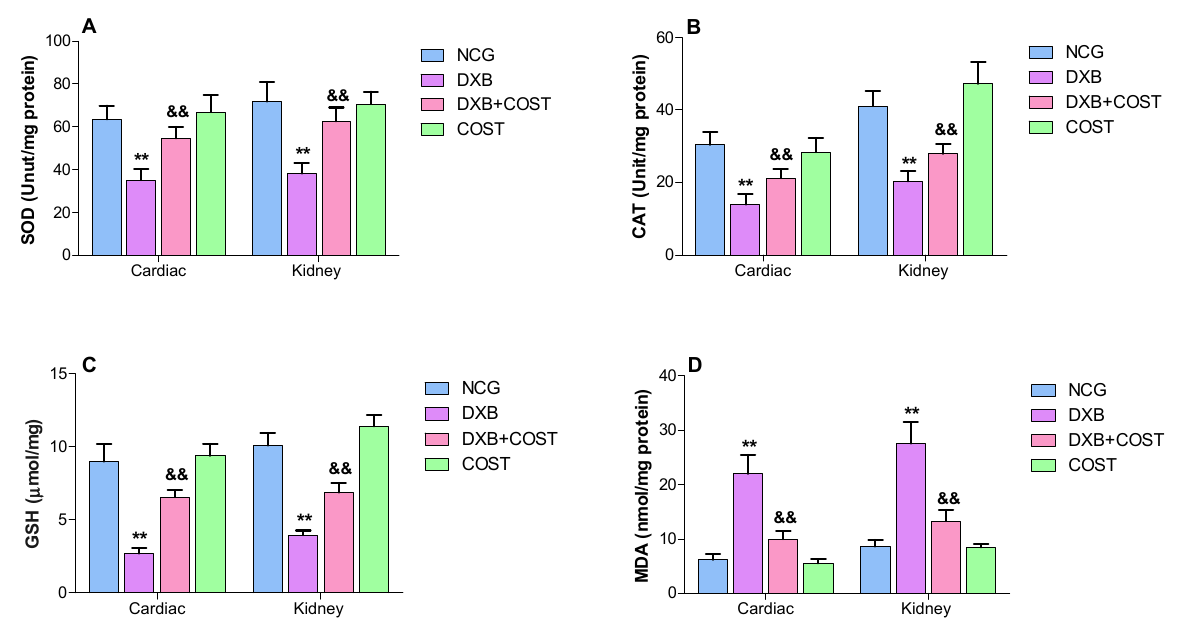
Figure 4. Effect of costunolide on: ( A ): SOD, ( B ): CAT, ( C ): GSH, ( D ): MDA. ** Statistically significant ( p < 0.01) compared with NCG and COST groups. && Statistically significant ( p < 0.01) compared with DXB group.